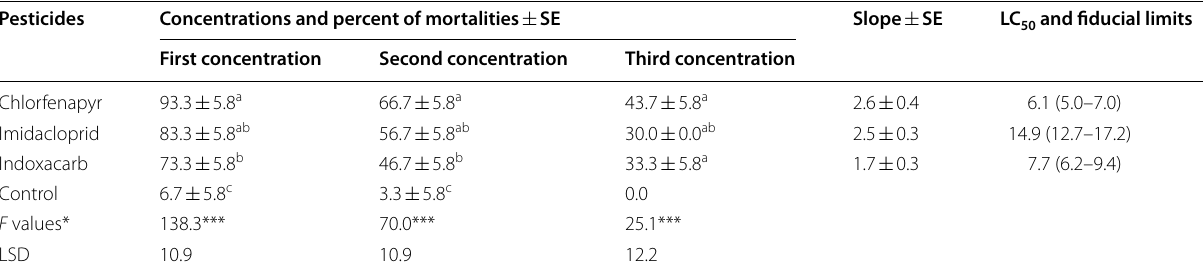
Table 2 Toxicity of some nanopesticide formulations against the conical snail, C. a cuta